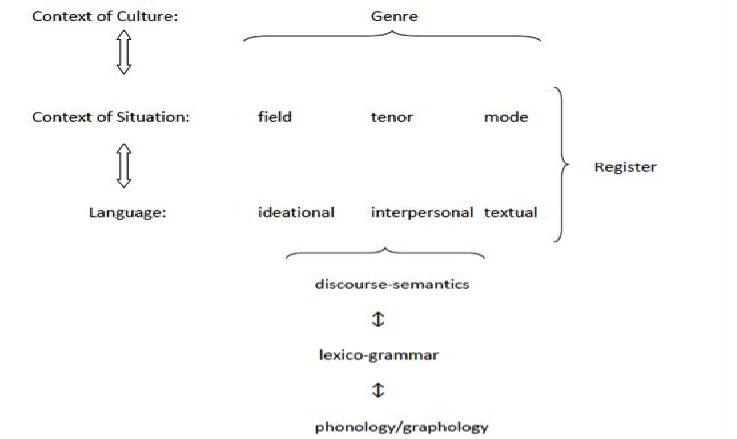
Figure 1. Context, meaning, and linguistic realization. Adapted from Genre: An introduction to history, theory, research, and pedagogy (p.33), by A. S. Bawarshi & M. J. Reiff, 2010, West Lafayette, IN: Parlor Press. Copyright 2010 by Parlor